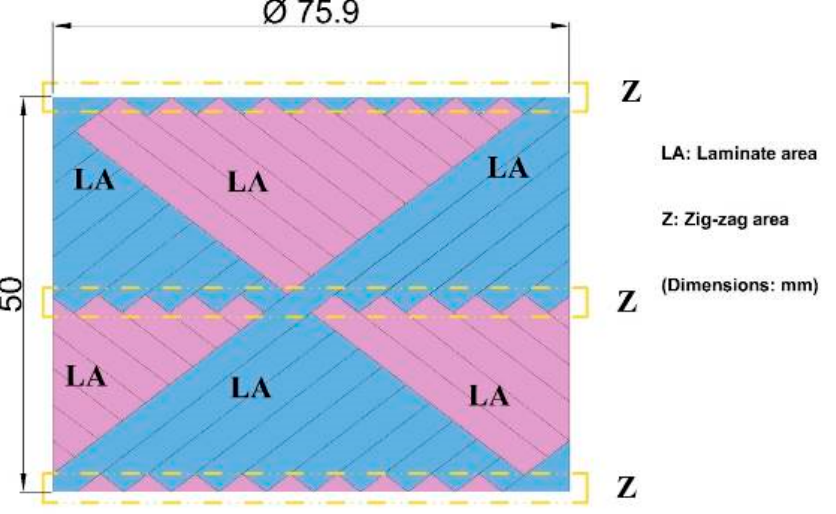
Figure 2. Filament winding variations on the outer surfaces of BFR/EP composite pipes.